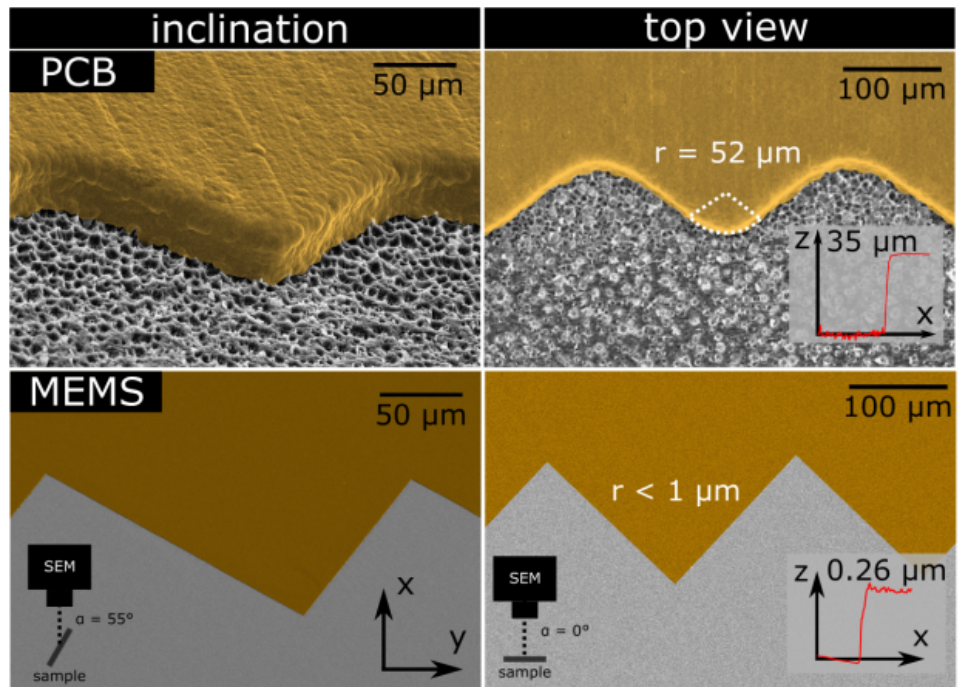
Figure 4. SEM images of the PCB-fabricated electrodes ( top ) compared to MEMS-realized electrodes ( bottom ). The pictures were taken with an inclination angle of α = 55° ( left ) and from top view ( right ). The two insets show profilometer measurements of the electrode